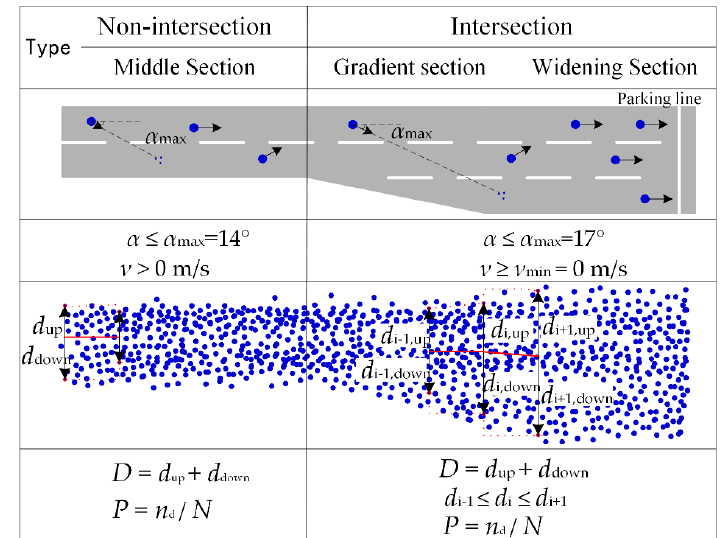
Figure 3. Description of characteristic parameters.